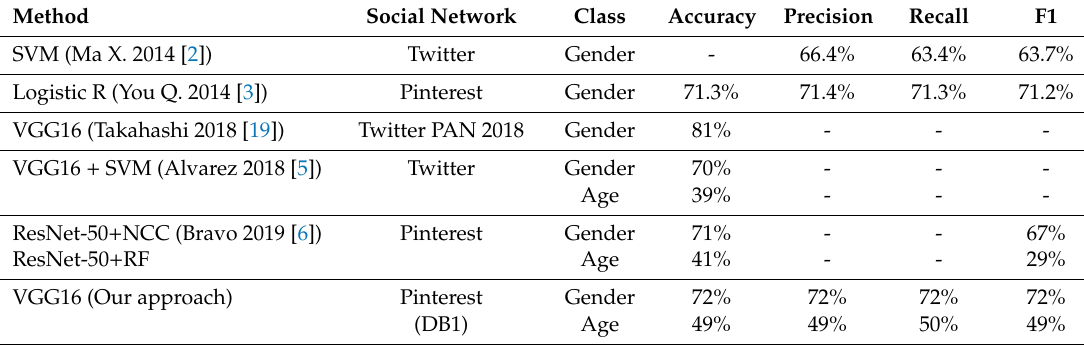
Table 5. Age and Gender prediction comparison with related approaches using Twitter or Pinterest image